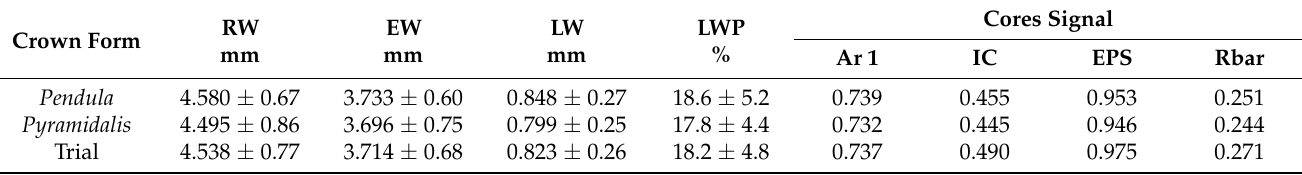
Table 2. Radial increments ( ± SD) and cores signal of the two Norway spruce crown forms. Crown Form